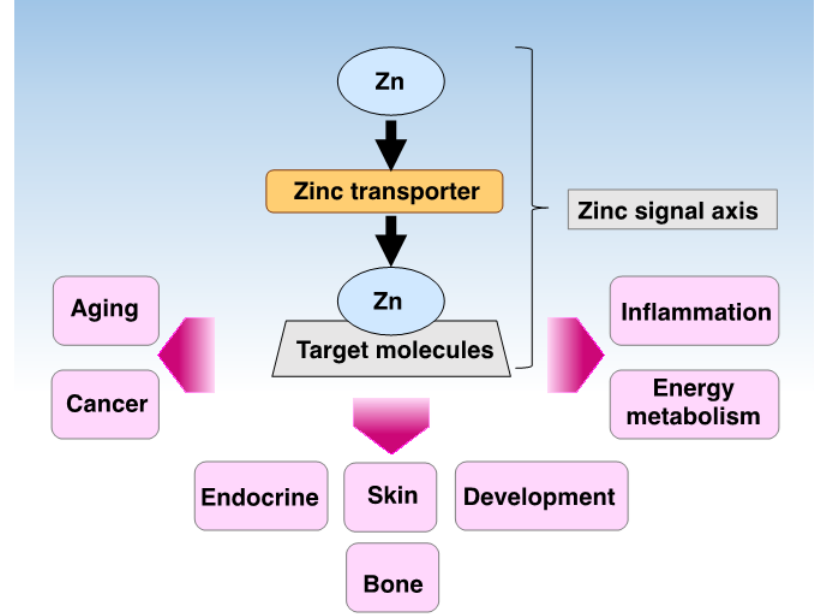
Figure 5. Summary of Zn signal axis in physiology and pathogenesis. Each Zn transporter regulates specific target molecules and cellular responses known as the “Zn-signal axis” [117] which transduces their signals to various physiological processes such as the bone and skin development, endocrine system, and aging. Dysfunction of the Zn signal results in impaired numerous cellular events, leading to various pathophysiological conditions such as inflammation, energy metabolism disorders, and cancer.